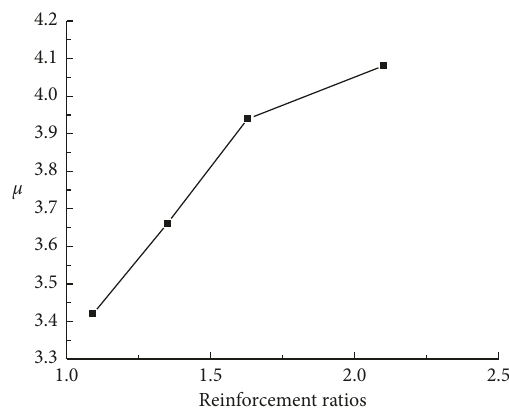
Figure 14: Relationship between various reinforcement ratios and ductility